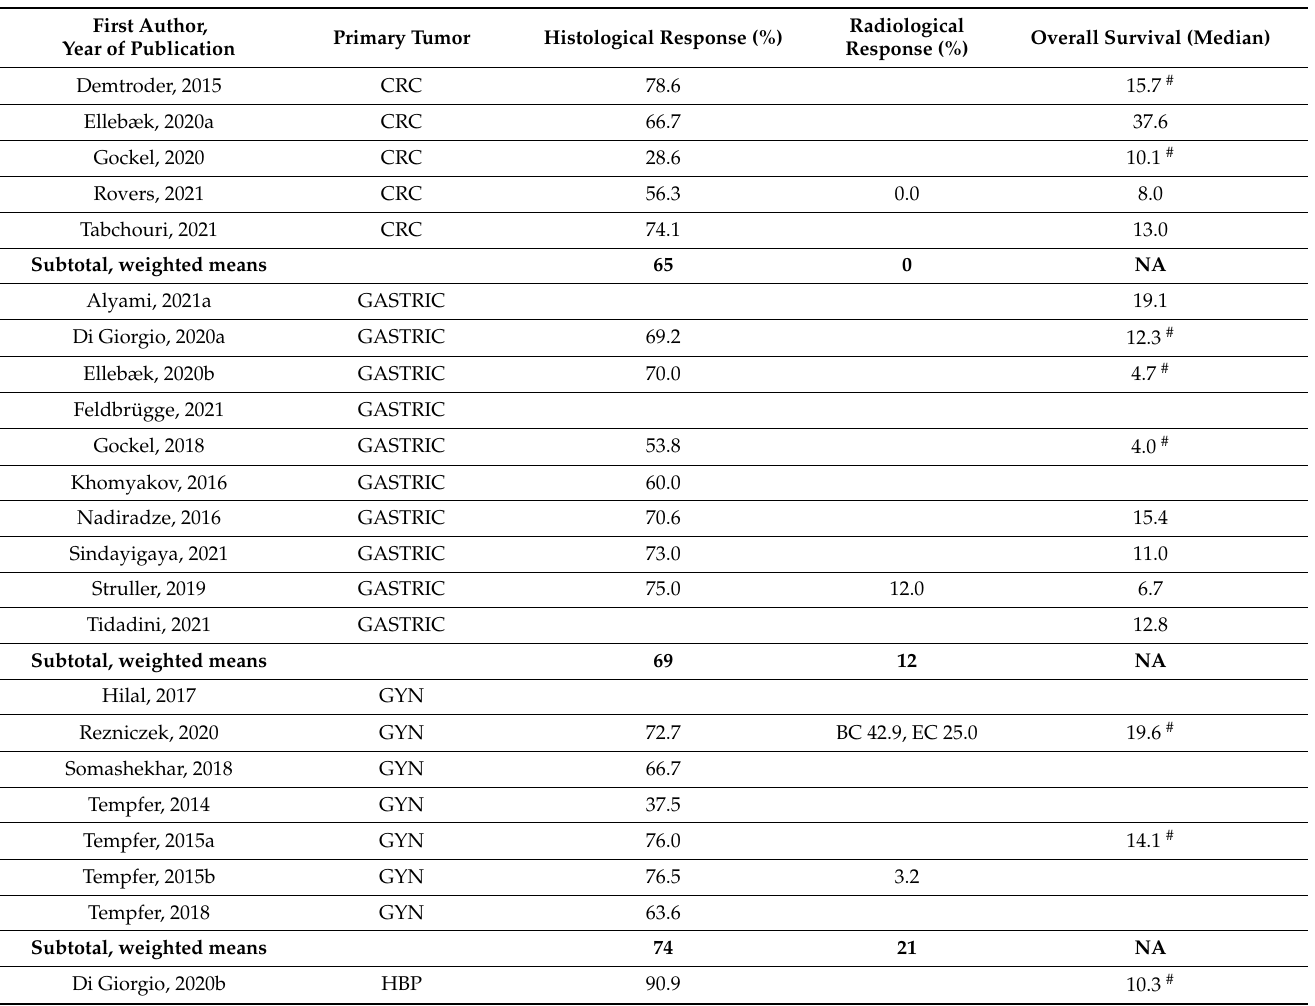
Table 4. Efficacy